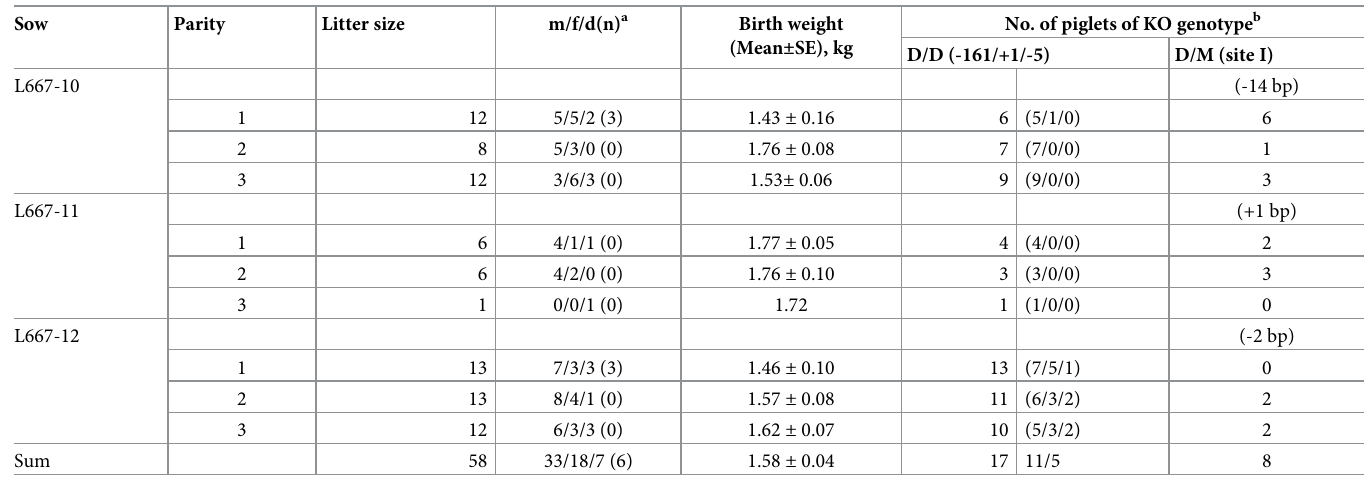
Table 3. Germline transmission and genotypes of F1 CMAH KO piglets. Sow